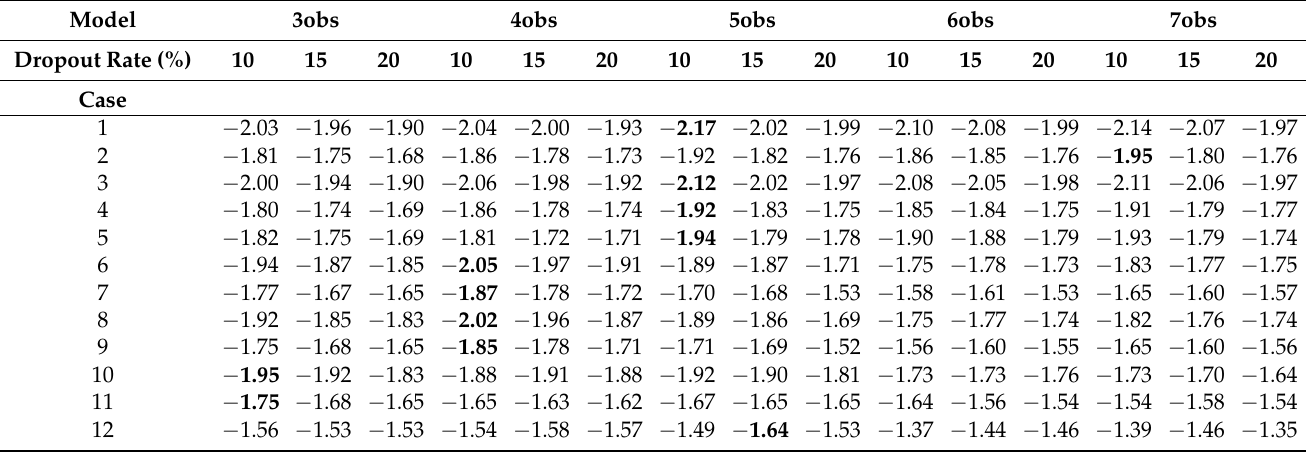
Table 1. Wahba’s error for each model (the best result for each model is defined in bold). Model